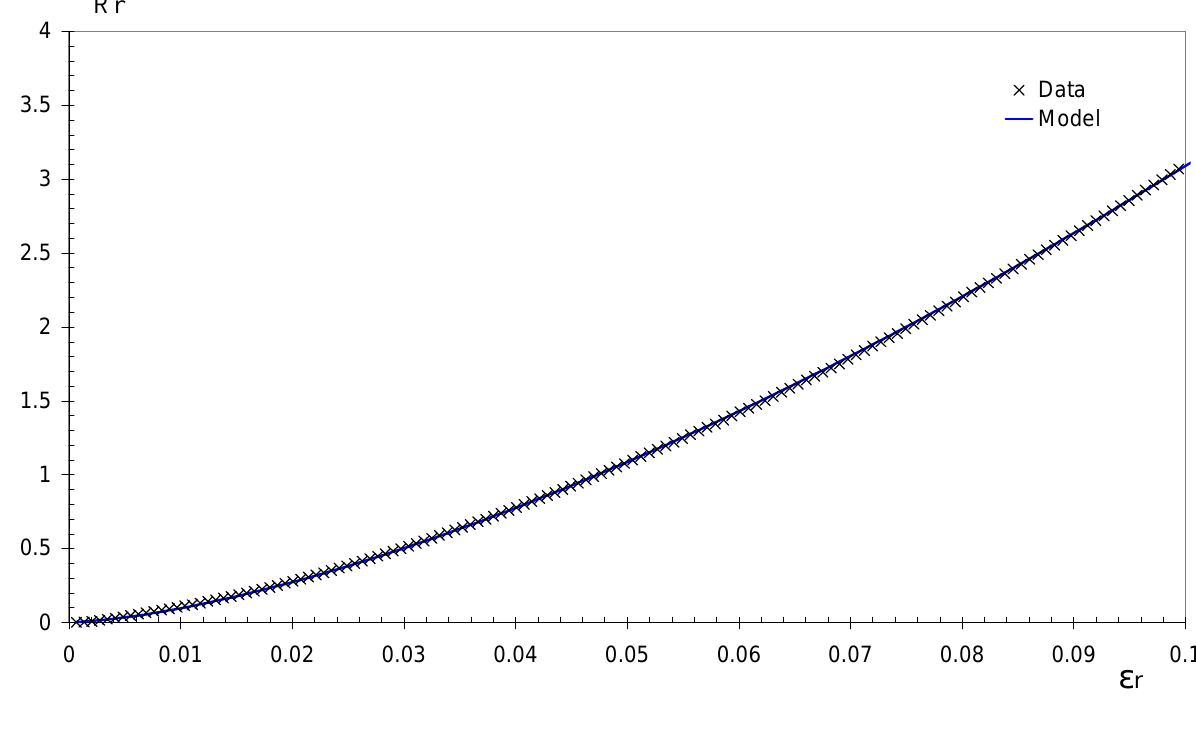
Figure 8. Modelling of the electromechanical behaviour for strain <